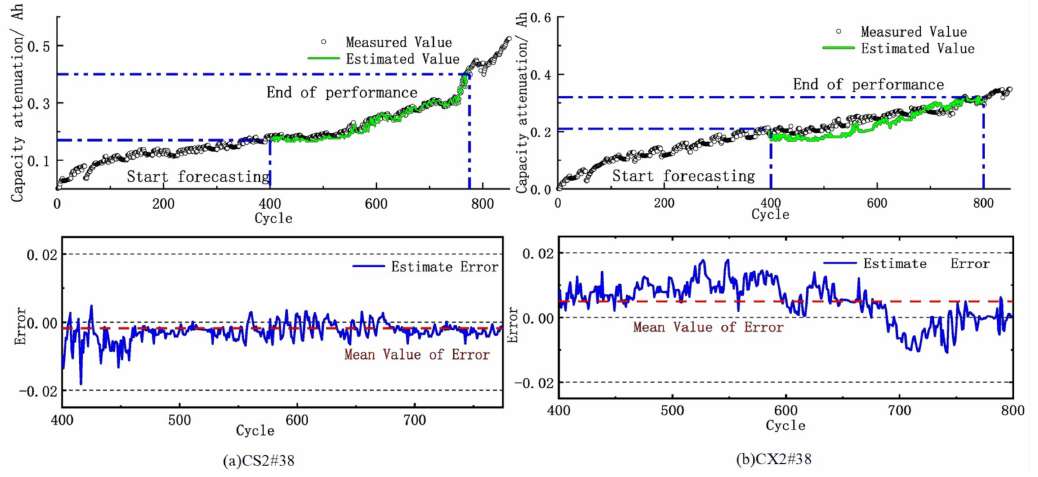
Figure 6. Capacity decay estimates and error for CS2#38 and CX2#38 batteries. The black part of the figure represents the attenuation value of the battery capacity, which increases with the aging of the battery. The green line in the figure represents the estimated value. In the estimation experiments of CS2#38 and CX2#38, the estimated curves of the two batteries have an excellent match result with the capacity attenuation curve until the batteries reach end of